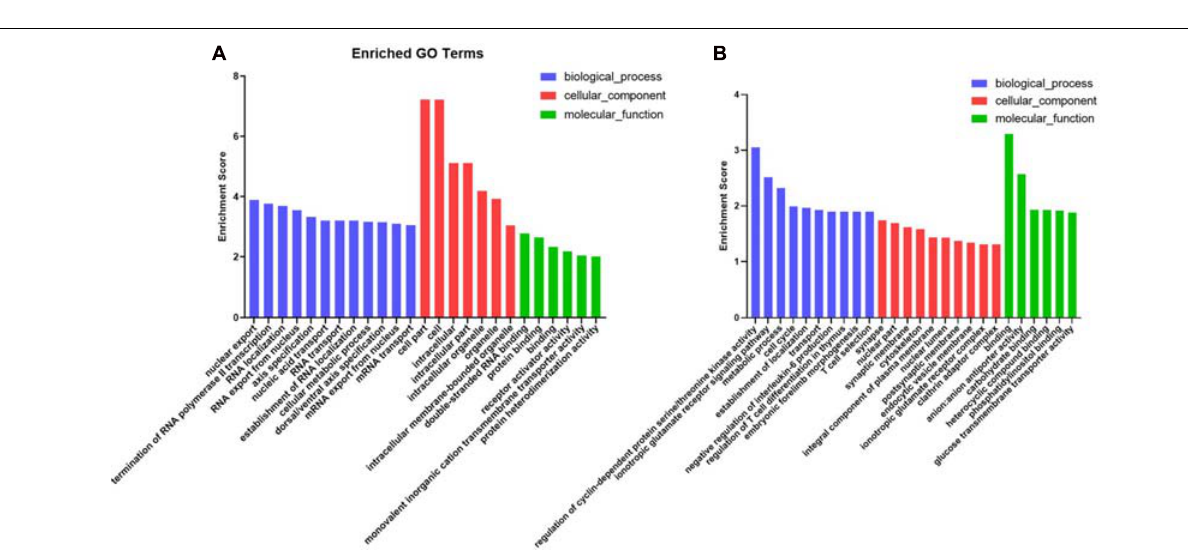
FIGURE 4 | Enriched GO terms of genes targeted by the significant differentially expressed miRNAs. (A) Target genes of M-EXO (miR-183, miR-425-3p, miR-1249, miR-451, miR-146a-5p, miR-221-5p); (B) Target genes of A-EXO (miR-28-5p, miR-145-5p, miR-149, miR-186, miR-499-5p).